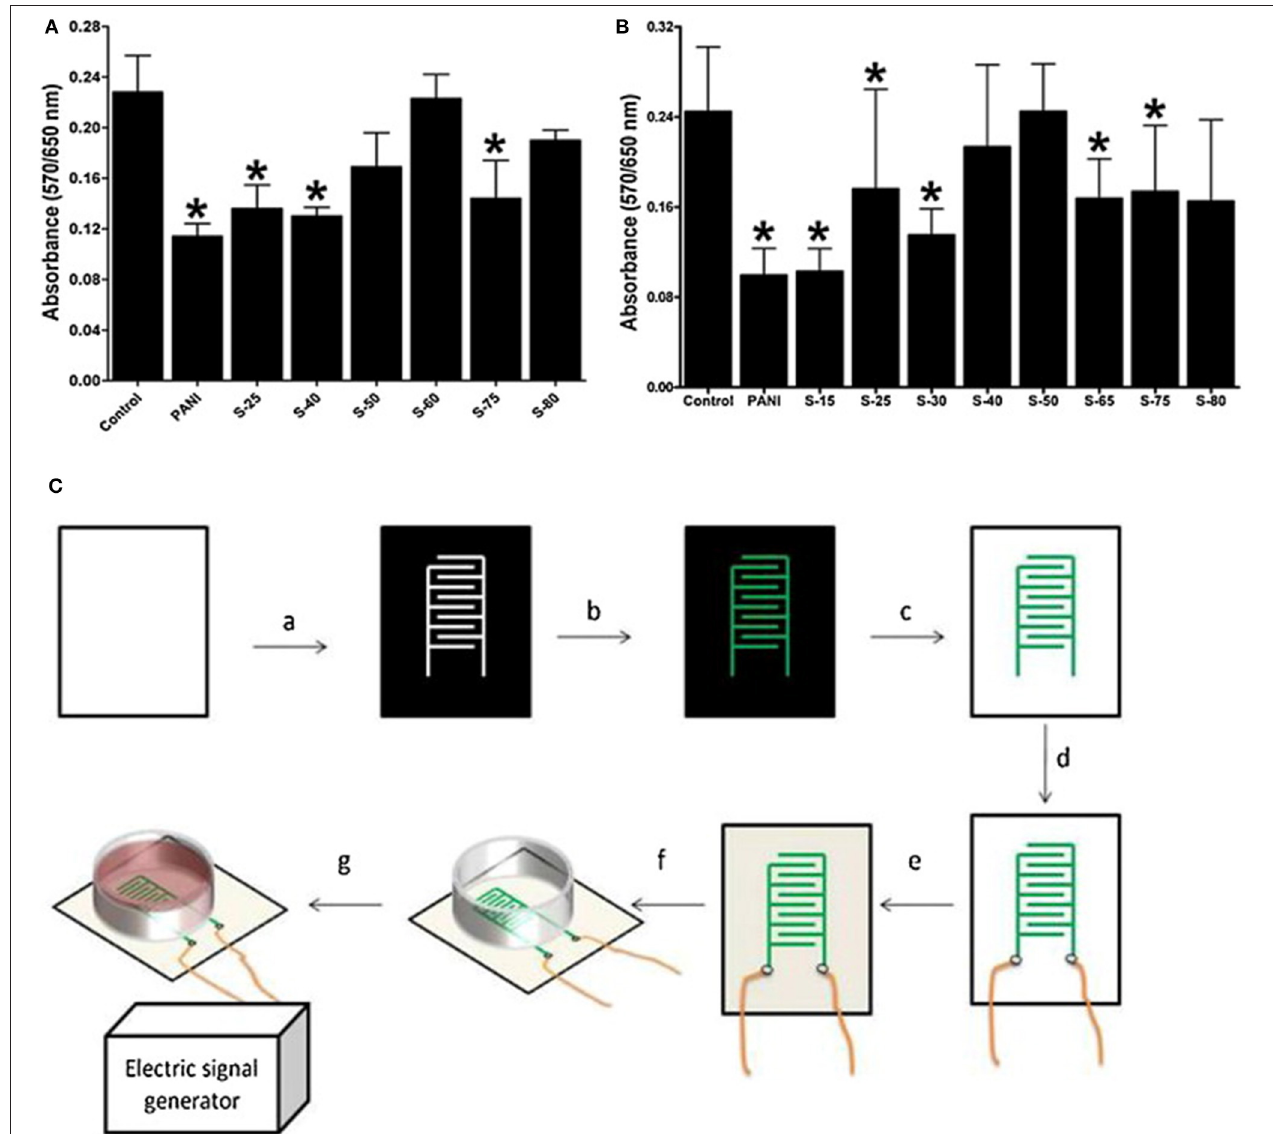
FIGURE 4 | SPAN biocompatibility with (A) . BMSCs and (B) . MC3T3-E1 cells, without electrical stimulation, after 5 days (C) . Fabrication of SPAN-based IDEs: (a) Printing on a PET transparency, (b) layer-by-layer deposition by in situ polymerization, (c) toner removal, (d) wire connexion with silver glue, (e) PLA coating, (f) electrode assembly, and (g) power connexion. Adapted from (105) with permission from the publisher. *represents a statistically significant difference in comparison with the control; (1-way RM-ANOVA and Newman–Keuls post-hoc analysis with p < 0.05, n =